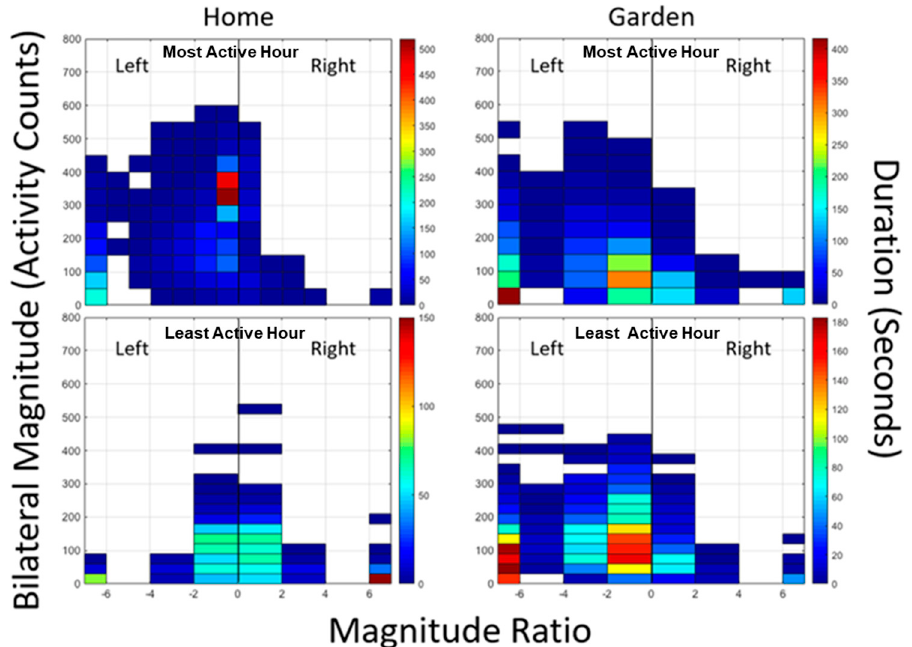
Figure 4. Activity trees for the most ( top ) and least ( bottom ) active measured hours from the home ( left ) and garden ( right ). The color scale indicates the duration of activity, with the reddest being the longest duration in seconds and the bluest being the shortest. Duration is scaled to the maximum for each hour.